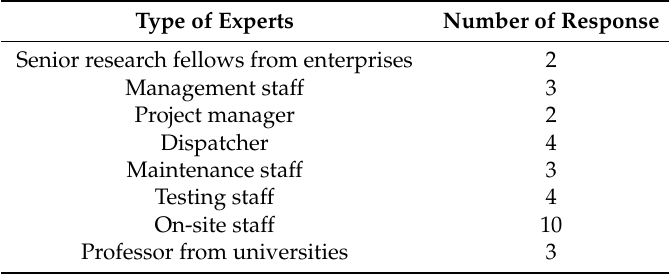
Table 2. Number of experts of different